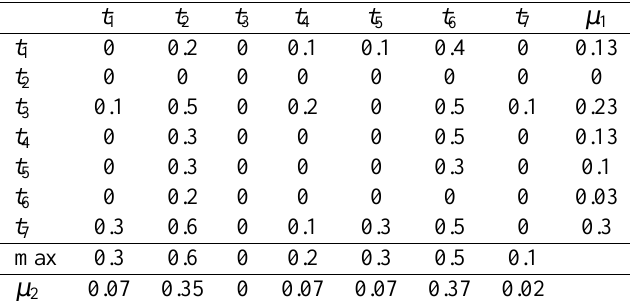
Table 3. Outranking degrees (Example 2a).